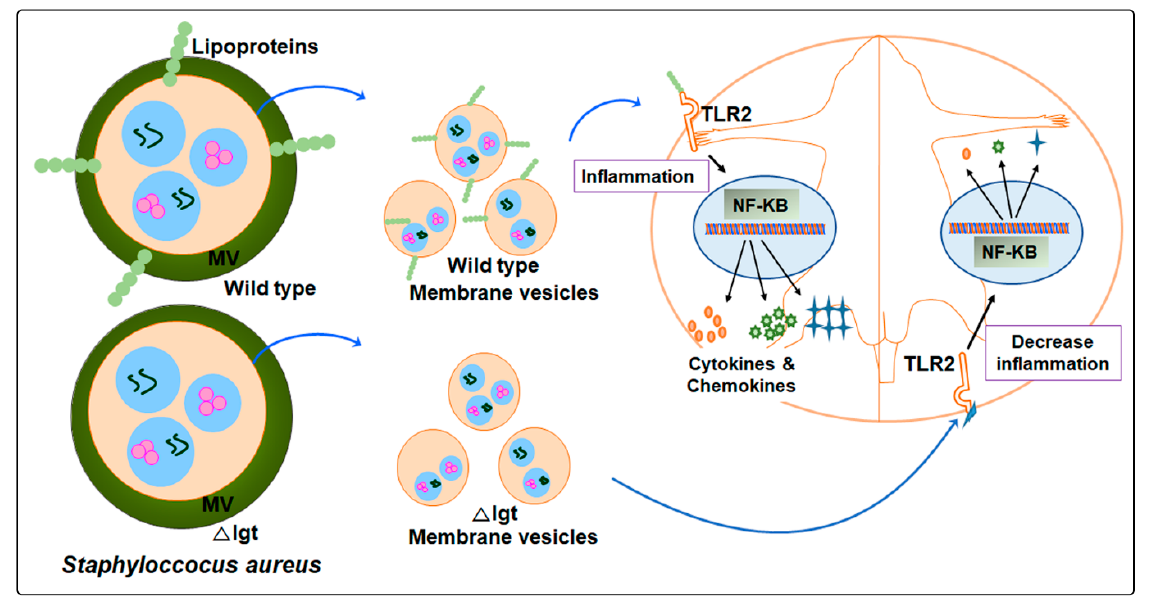
Figure 6. A proposed model explaining the role of S. aureus EVs lipoproteins in inducing inflammation through TLR2 signaling both in vitro and in vivo. S. aureus EVs contain proteins, nucleic acids, and lipoproteins. The wild-type Newman EVs harbor lipoproteins responsible for inducing inflammation in mice through TLR2, resulting in the release of a vast amount of chemokines and cytokines, whereas Δ lgt EVs, lacking lipoproteins, result in decreased inflammation with sub- sequent reduced production of chemokines and cytokines. —Proteins; —Nucleic acids; MV: membrane